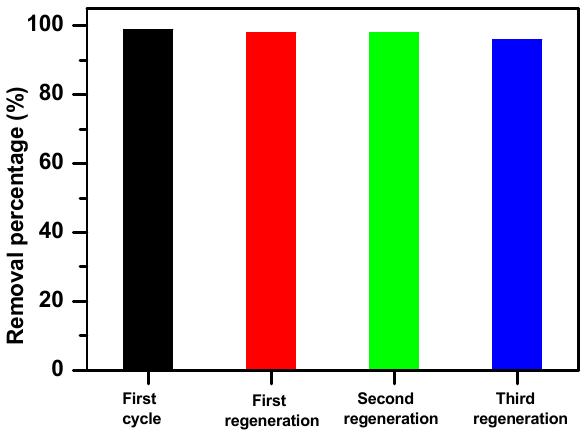
Figure 10. Recycled efficiencies of Fe 2 (MoO 4 ) 3 for the removal of methylene blue (60 ppm, 0.001 g, 30 min).